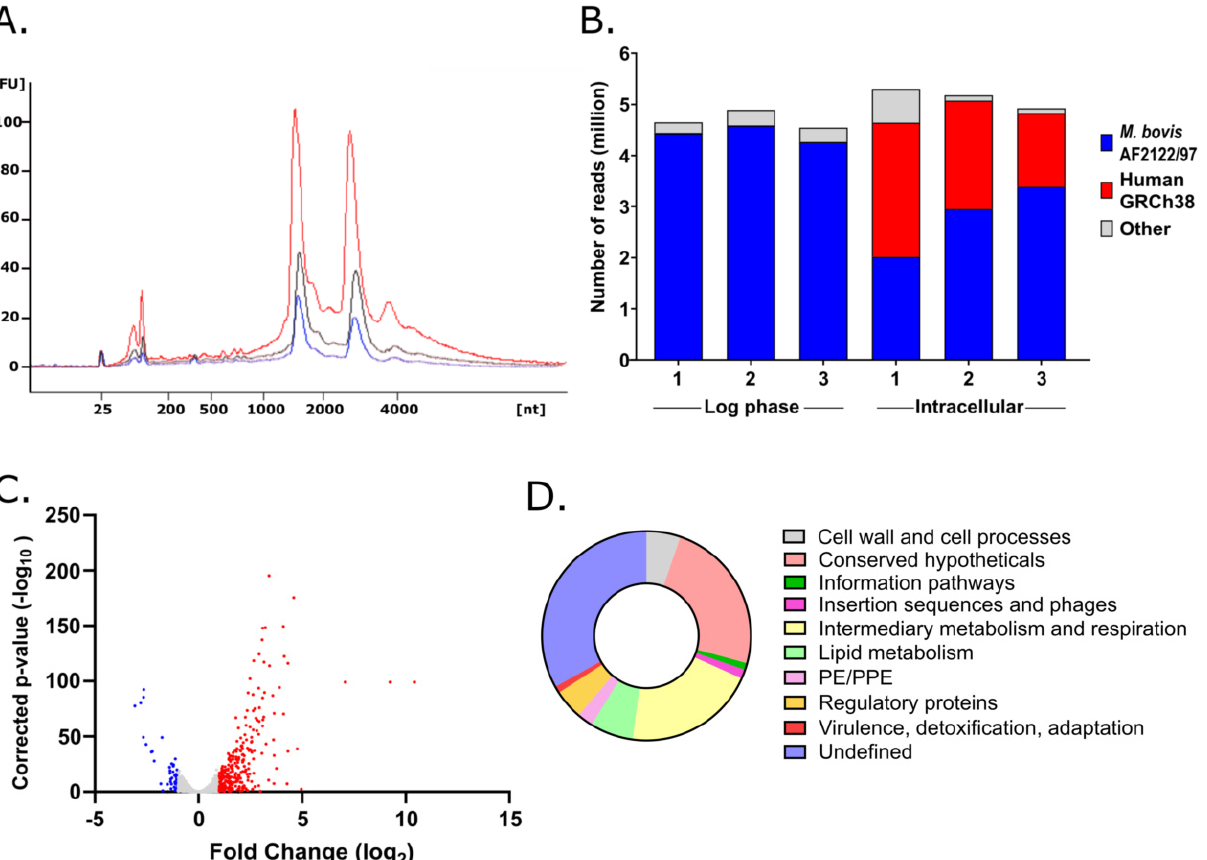
Figure 1 . M. bovis BCG intracellular mRNA profile. ( A ). Bioanalyzer plot demonstrating size distribution of RNA extracted from infected THP-1 macrophages, showing defined bacterial ribosomal peaks of replicate extractions. Intracellular replicate 1 (black), 2 (blue), 3 (red). ( B ). Number of RNAseq reads mapped to M. bovis (blue) and human (red) genomes from each independent biological replicate. ( C ). Volcano plot identifying significantly differentially expressed genes comparing intracellular to log phase M. bovis BCG. Fold change (log2) >1 highlighted in red, < − 1 highlighted in blue, non-significant in grey. ( D ). Distribution of functional categories represented by genes significantly induced in M. bovis BCG after macrophage infection (functional categories coloured clockwise).